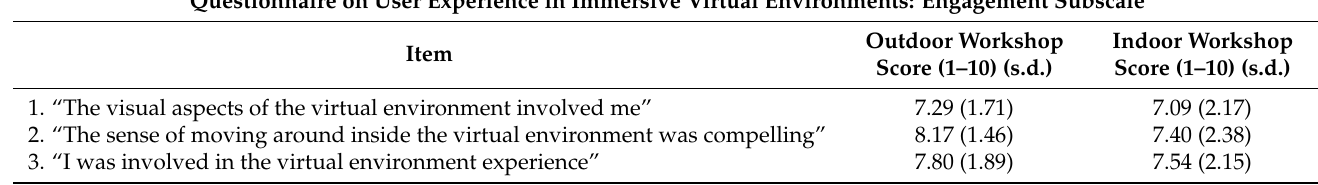
Table 4. Questionnaire on User eXperience in Immersive Virtual Environments: Engagement